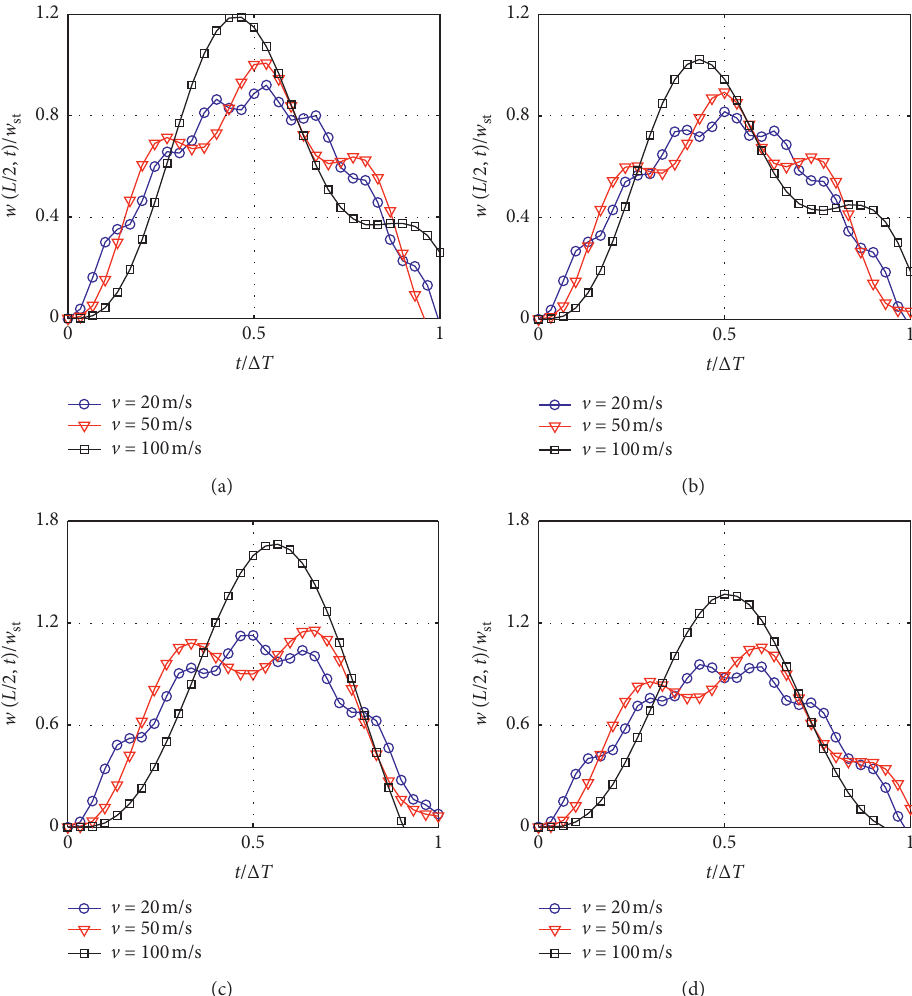
Figure 5: Time histories for midspan dimensionless deflection for various moving load speeds. (a) (4-1-4), n